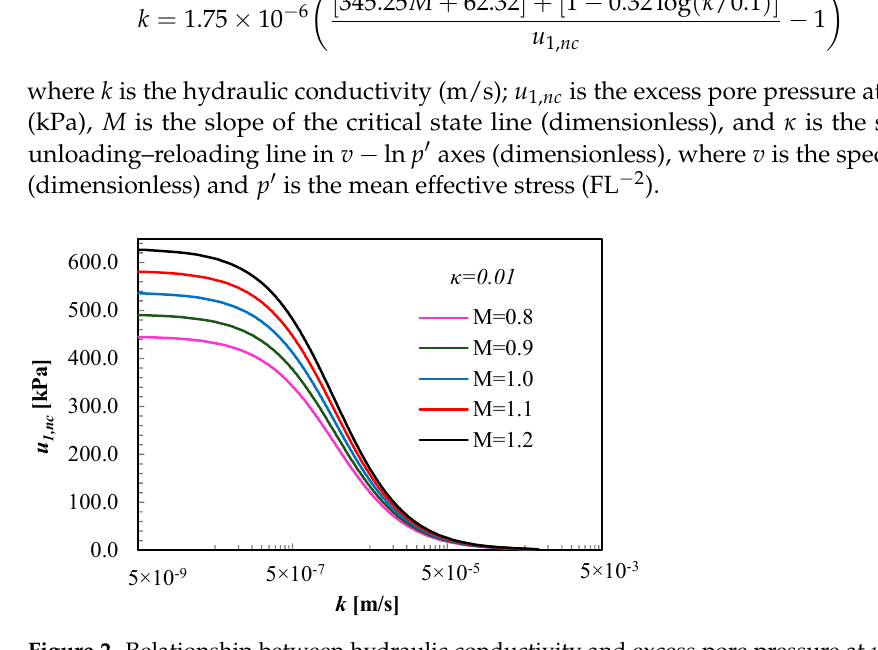
Figure 2. Relationship between hydraulic conductivity and excess pore pressure at u 1 position in NC soils.